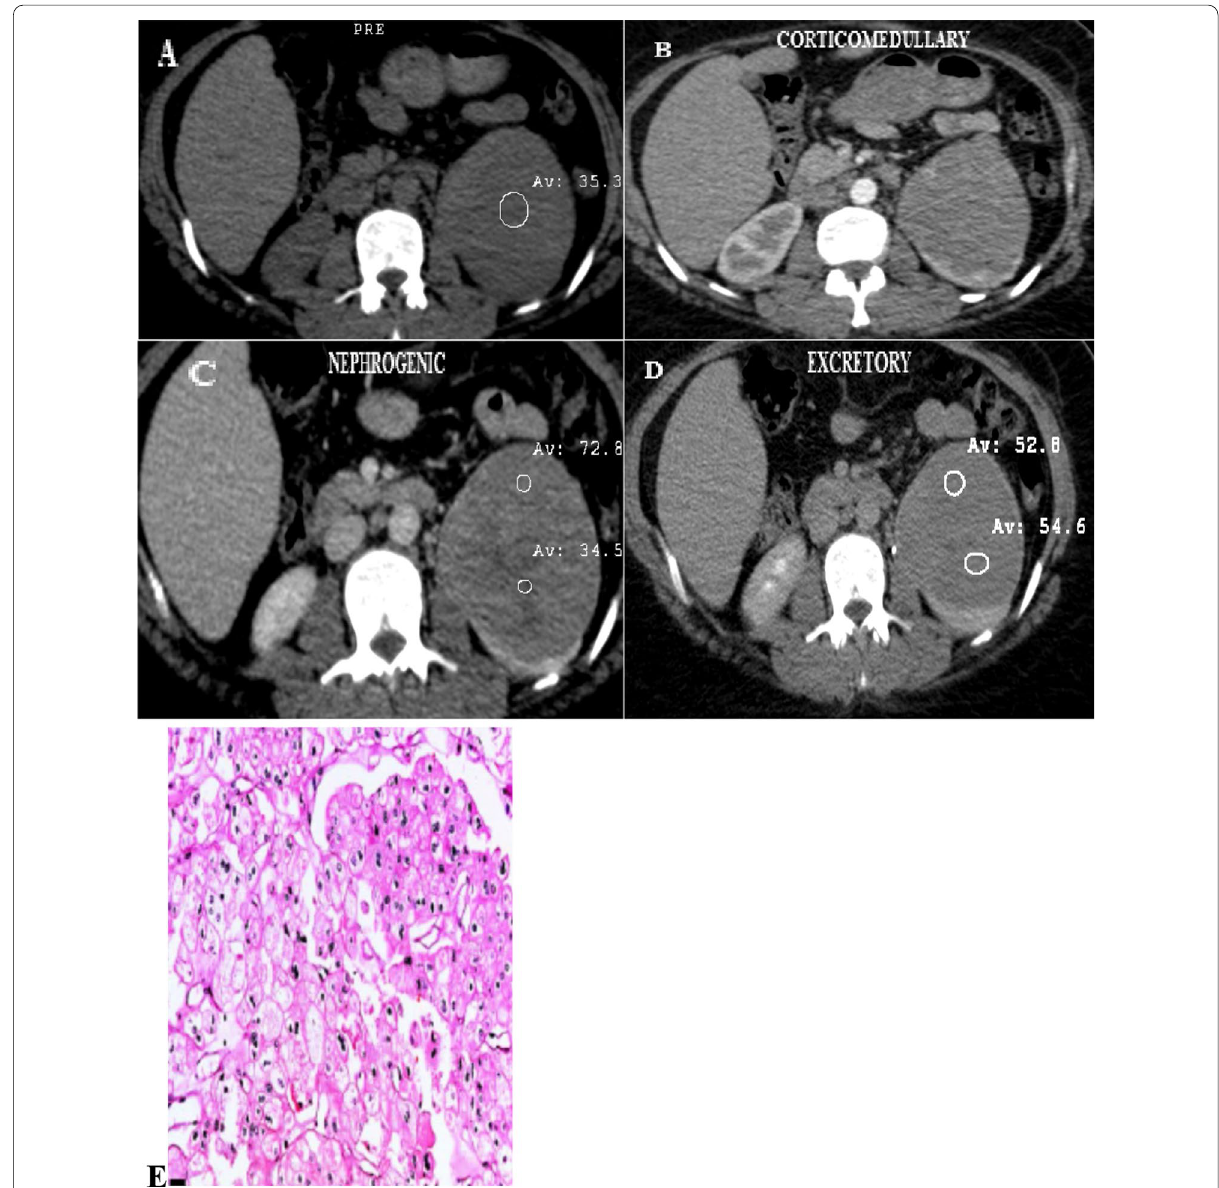
Fig. 4 Chromophobe RCC. A 46-year old male patient presented with left loin pain. o Pre enhanced scan ( A ) shows left renal large heterogeneous mass, mean attenuation (35 HU). The mean attenuation value of the lesion is 123 HU in the corticomedullary phase ( B ), 93 HU In the nephrographic phase ( C ), 54 HU in the excretory phase ( D ). Quantitative findings indicate the high likelihood of the non-Clear subtypes RCCs. Patient underwent open total nephrectomy. Histopathological diagnosis: Chromophobe renal cell carcinoma (Image E